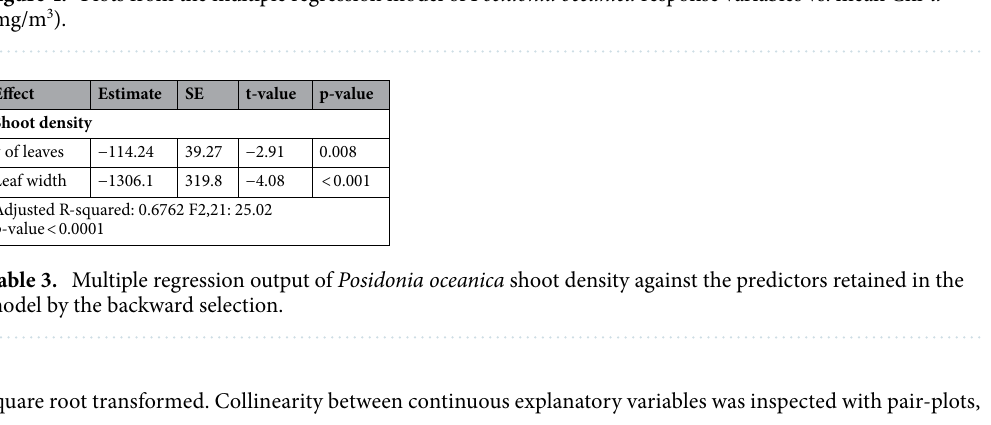
square root transformed. Collinearity between continuous explanatory variables was inspected with pair-plots,